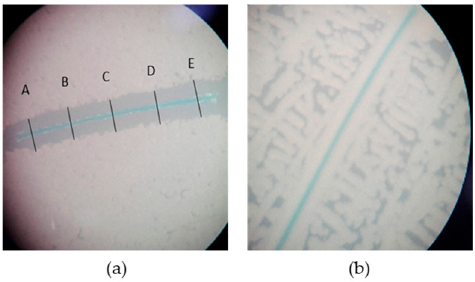
Figure 3. Multifilament sutures incubated with S. aureus at 37 °C for 24 h on Mueller-Hinton-agar: ( a ) depicts a totarol-PLGA coated suture with a clear zone of inhibition, measured at five different sites (A, B, C, D, E), and ( b ) shows an uncoated suture without a zone of inhibition. Mean diameter = [(A + B + C + D + E)/5] ± SEM.